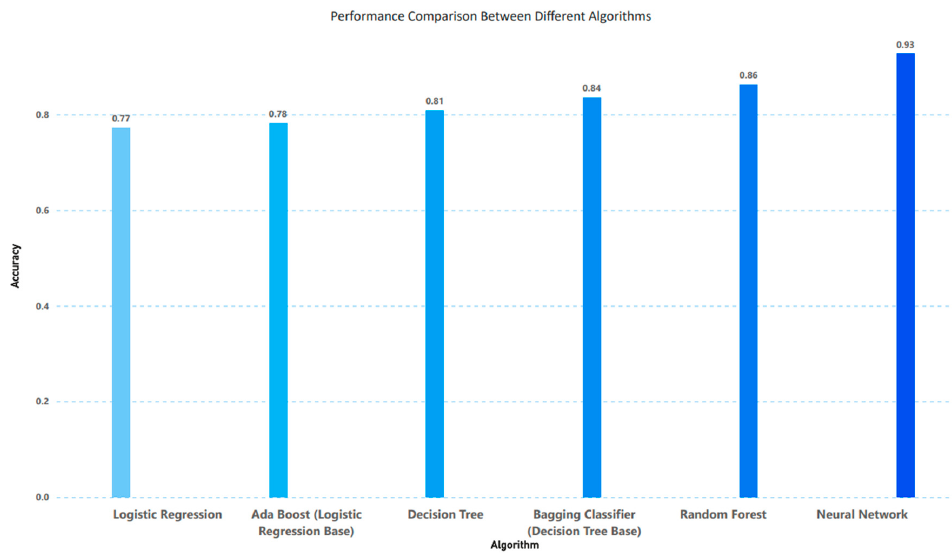
Figure 22. Performance comparison between various approaches. Neural network provides the best Accuracy (0.927), Precision (0.92), Recall (0.95), and F1 Score (0.93). The second highest score is obtained from the random forest (0.863). The poorest accuracy score of (0.772) is of the logistic regression algorithm.